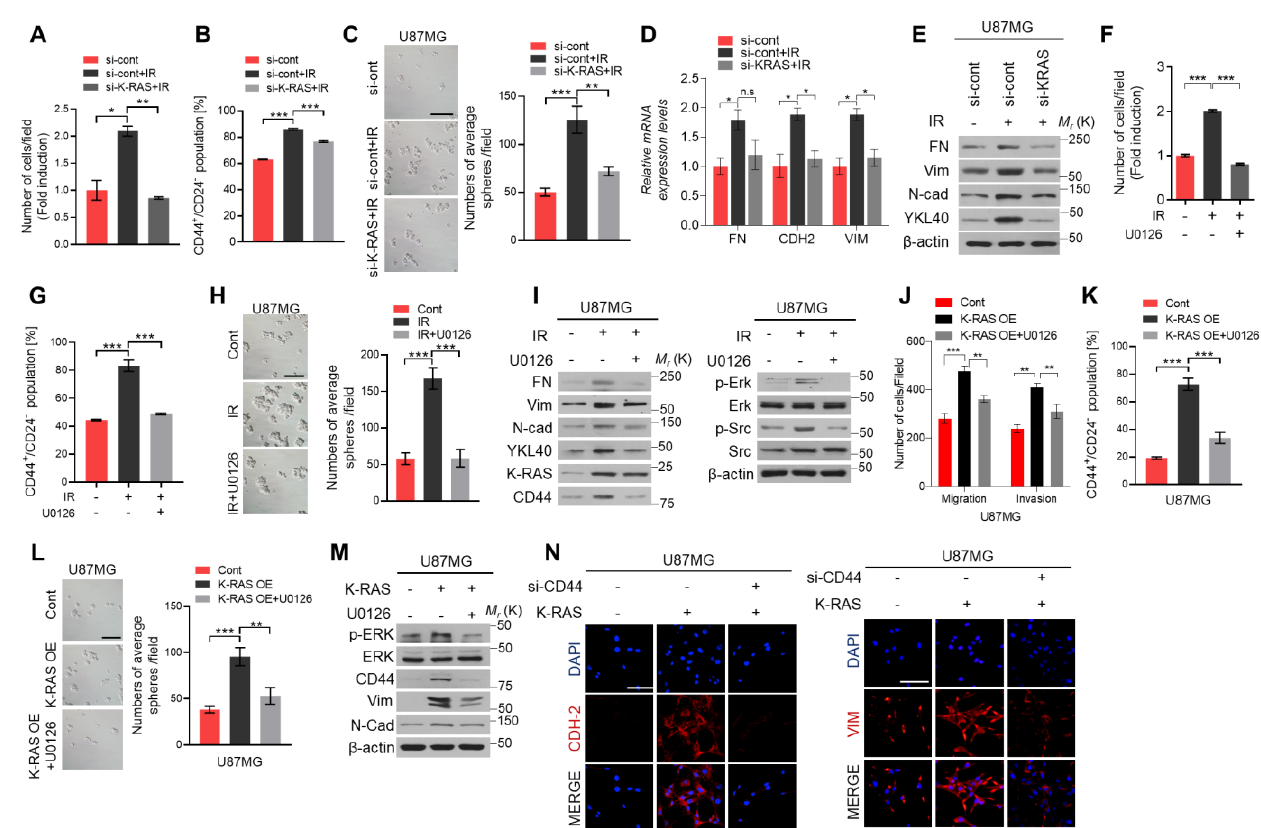
Figure 3. Radiation-induced acquisition of invasiveness and stemness is regulated by K-RAS/ERK/CD44 axis. ( A ). Invasion assay was performed using the radiation treated-U87MG cells with or without K-RAS expression. ( B , C ). FACS analysis and sphere formation assay were used to measure the percentage of CD44 + /CD24 − cells number and the number of spheres using the same condition samples. ( D , E ). qRT-PCR and western blot analysis of EMT markers, FN, CDH2, and VIM, expression using the radiation treated cells with blocking K-RAS expression. ( F–H ). Invasion assay, FACS analysis, and sphere formation assay were performed to assess the invasiveness and stemness features with or without the ERK inhibitor treatment in IR treated-GBM cells. I . Western blot analysis was used to check the expression of mesenchymal markers, p-ERK and p-SRC. ( J–L ). Invasion assay, FACS analysis, and sphere formation assay were performed to assess the invasiveness and stemness features in the K-RAS-overexpressing U87MG cells with or without U0126 treatment, respectively. ( M ). Western blot analysis of p-ERK, ERK, CD44, Vim, and N-cad expression using the same condition samples of above. ( N ). Representative ICC staining images of CDH-2 and VIM expression after blocking CD44 expression in K-RAS-overexpressing U87MG cells. β -actin was used as a control for normalization of expression. * p < 0.05, ** p < 0.01, *** p < 0.001, n.s., not significant. A two-tailed Student’s t-test was used to compare data between two groups, and ANOVA was used for multiple